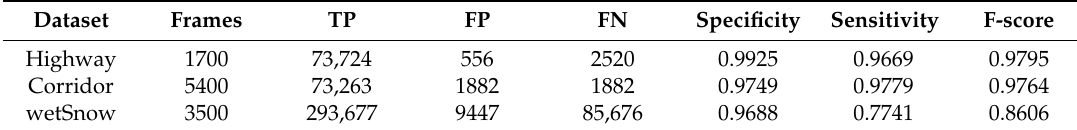
Table 4. Performance metrics.